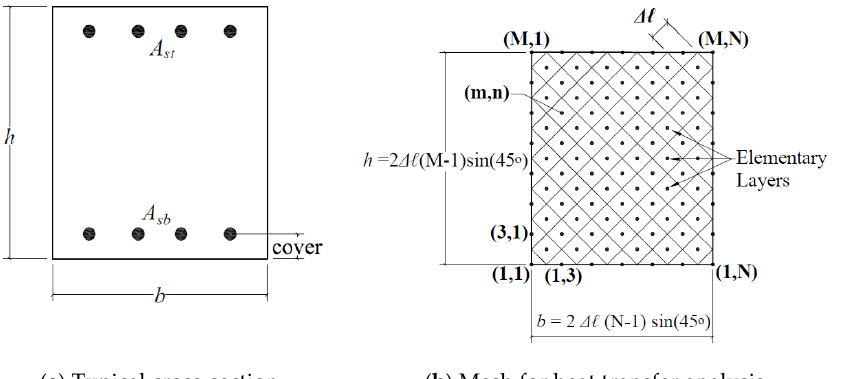
Table 1 details the mechanical and geometrical properties of the selected rectangular and circular sections discussed in this paper.